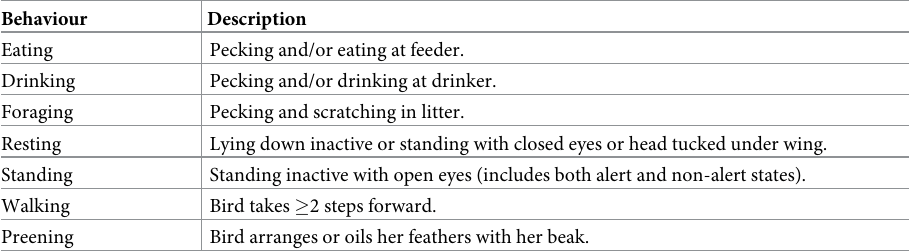
Table 3. Ethogram used for the data